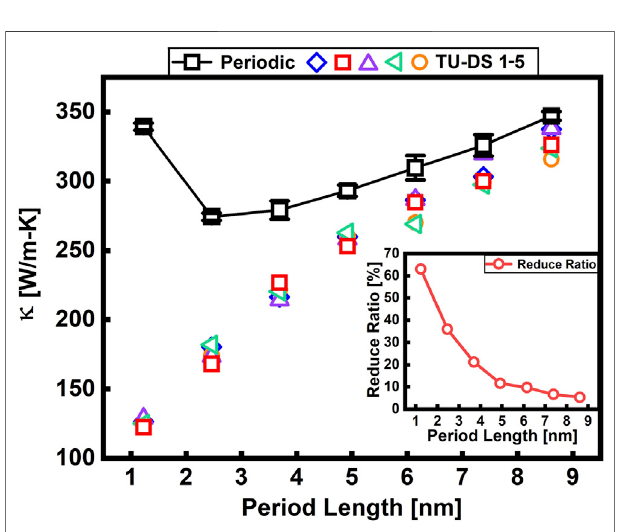
FIGURE 2 | The effect of L p on the thermal conductivity of periodic structure and TU-DS at 300 K. The inset shows the relative difference between the thermal conductivity of the TU-DS and the corresponding periodic structure with different L p . The relative difference is de fi ned as ( κ − κ ) / κ periodic periodic × 100%.Theerrorbarsarethestandarddeviations TU − DS of fi ve independent simulations with different initial conditions.